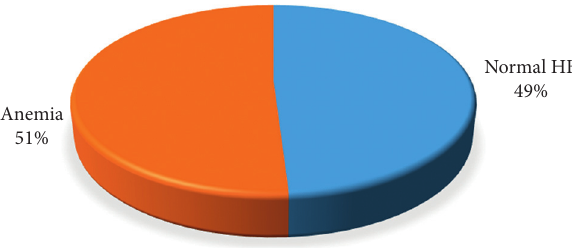
Figure 1: Prevalence of anemia among pregnant women who visit Bost Hospital for delivery ( n � 787).